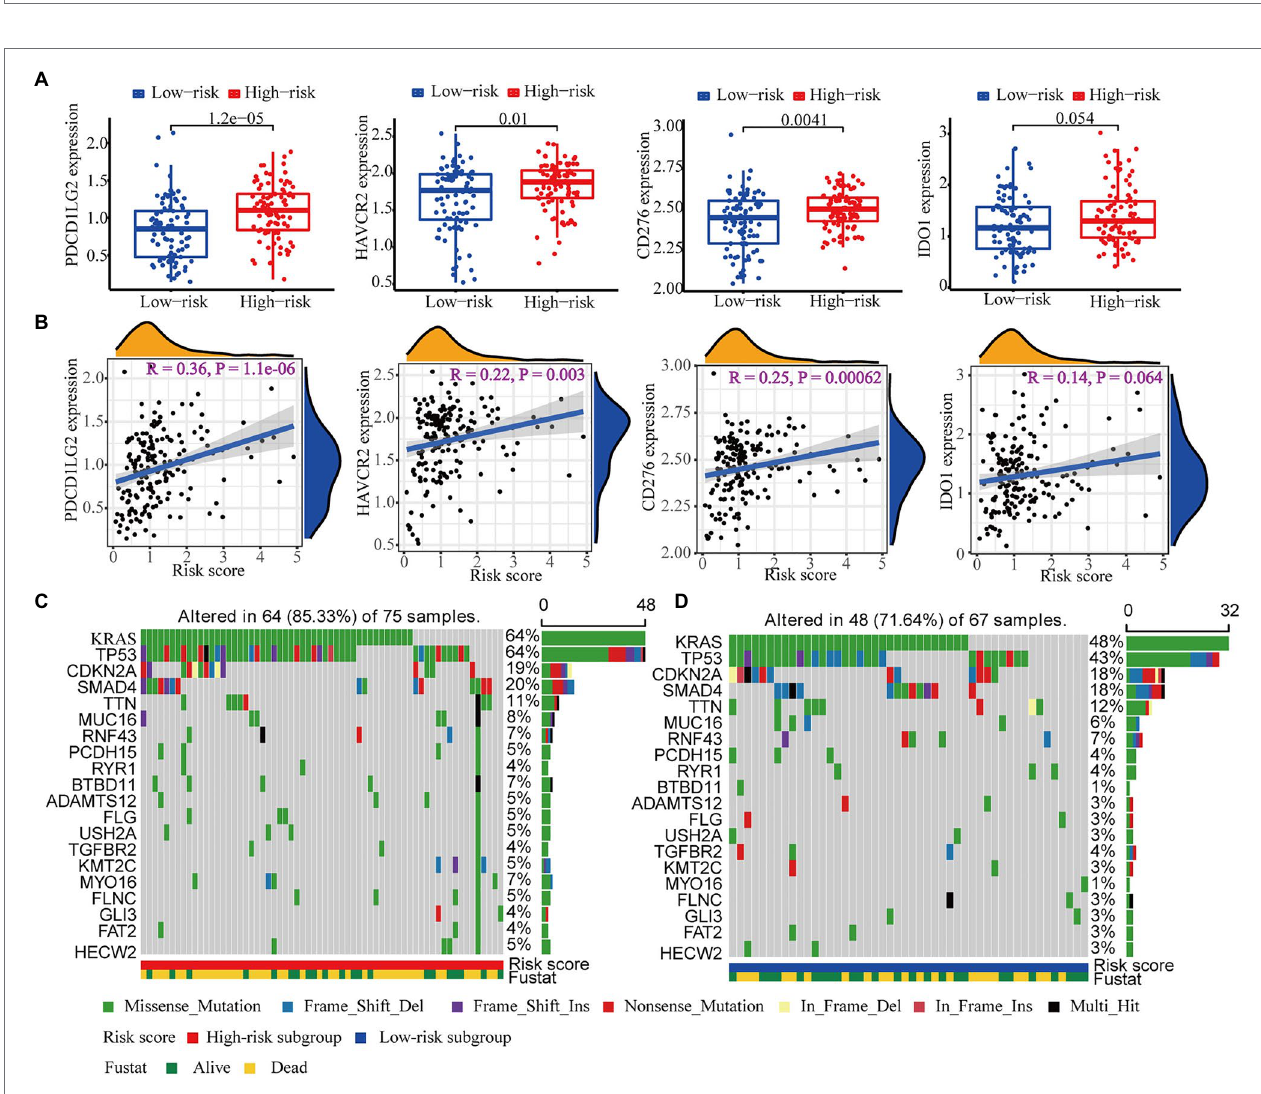
FIGURE 9 | The potential mechanisms of different clinical outcomes between the high- and low-risk subgroups. (A) The volcano plot of differentially expressed genes between the high- and low-risk groups. Gene ontology (GO) enrichment analysis for differentially expressed genes between the high- and low-risk groups. (B) Biological process (BP), (C) cellular component (CC), (D) : molecular function (MF). (E) Gene set enrichment analysis (GSEA): 15 pathways were identified to be significantly activated in the high-risk group. Comparison with the single-sample gene set enrichment analysis (ssGSEA) scores between the different risk groups. The scores of (F) 16 immune cells and (G) 13 immune-related functions are displayed in boxplots. * p < 0.05; ** p < 0.01; and *** p < 0.001.